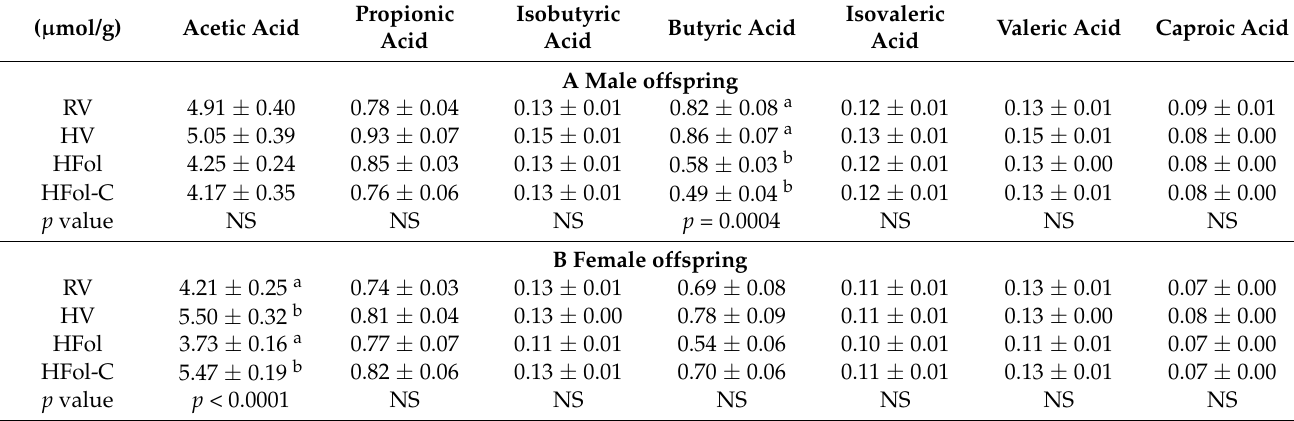
Table 2. Concentrations of short-chain fatty acids (acetic acid, propionic acid, isobutyric acid, butyric acid, isovaleric acid, valeric acid and caproic acid) in µ mol/g at 12 weeks post-weaning in (A) male and (B) female